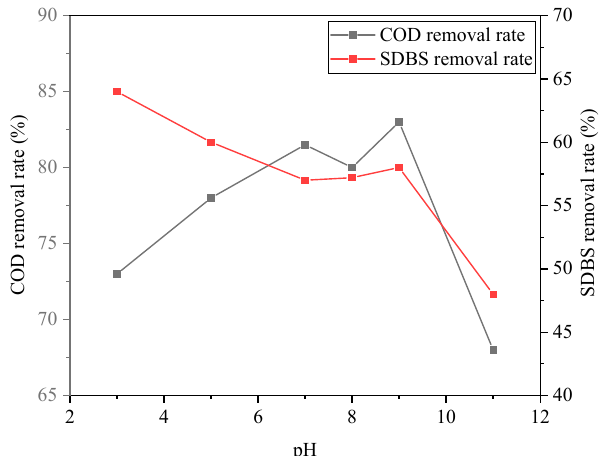
Figure 8. Effect of pH on removal rates of COD and SDBS.